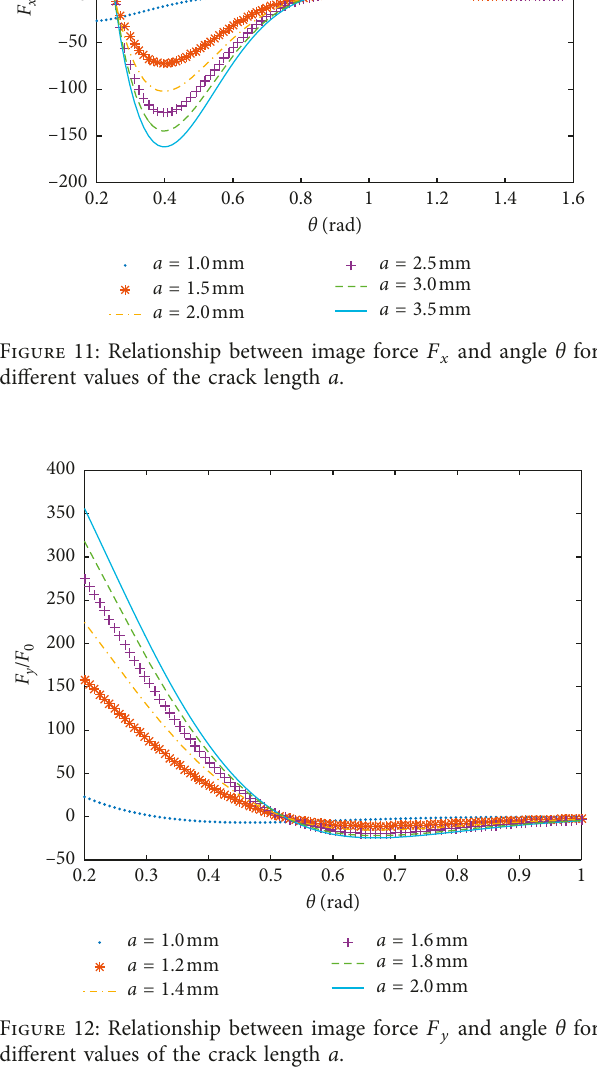
y and angle θ for